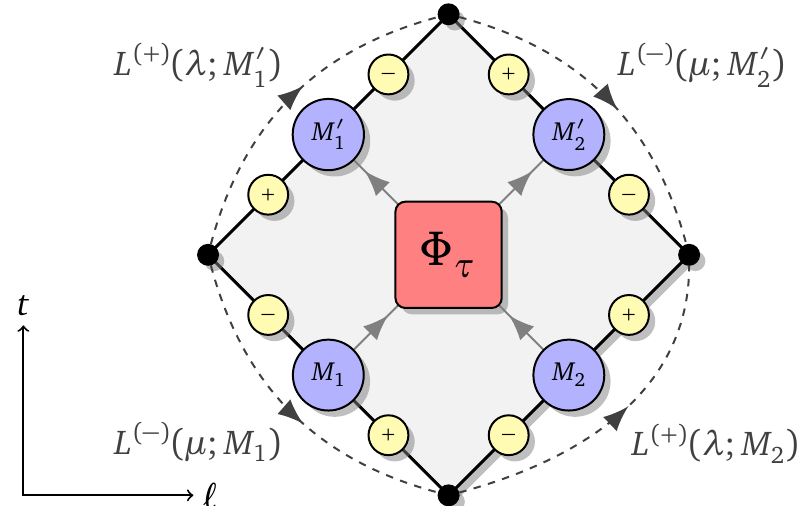
pertain to M time-shifted 1,2 1,2